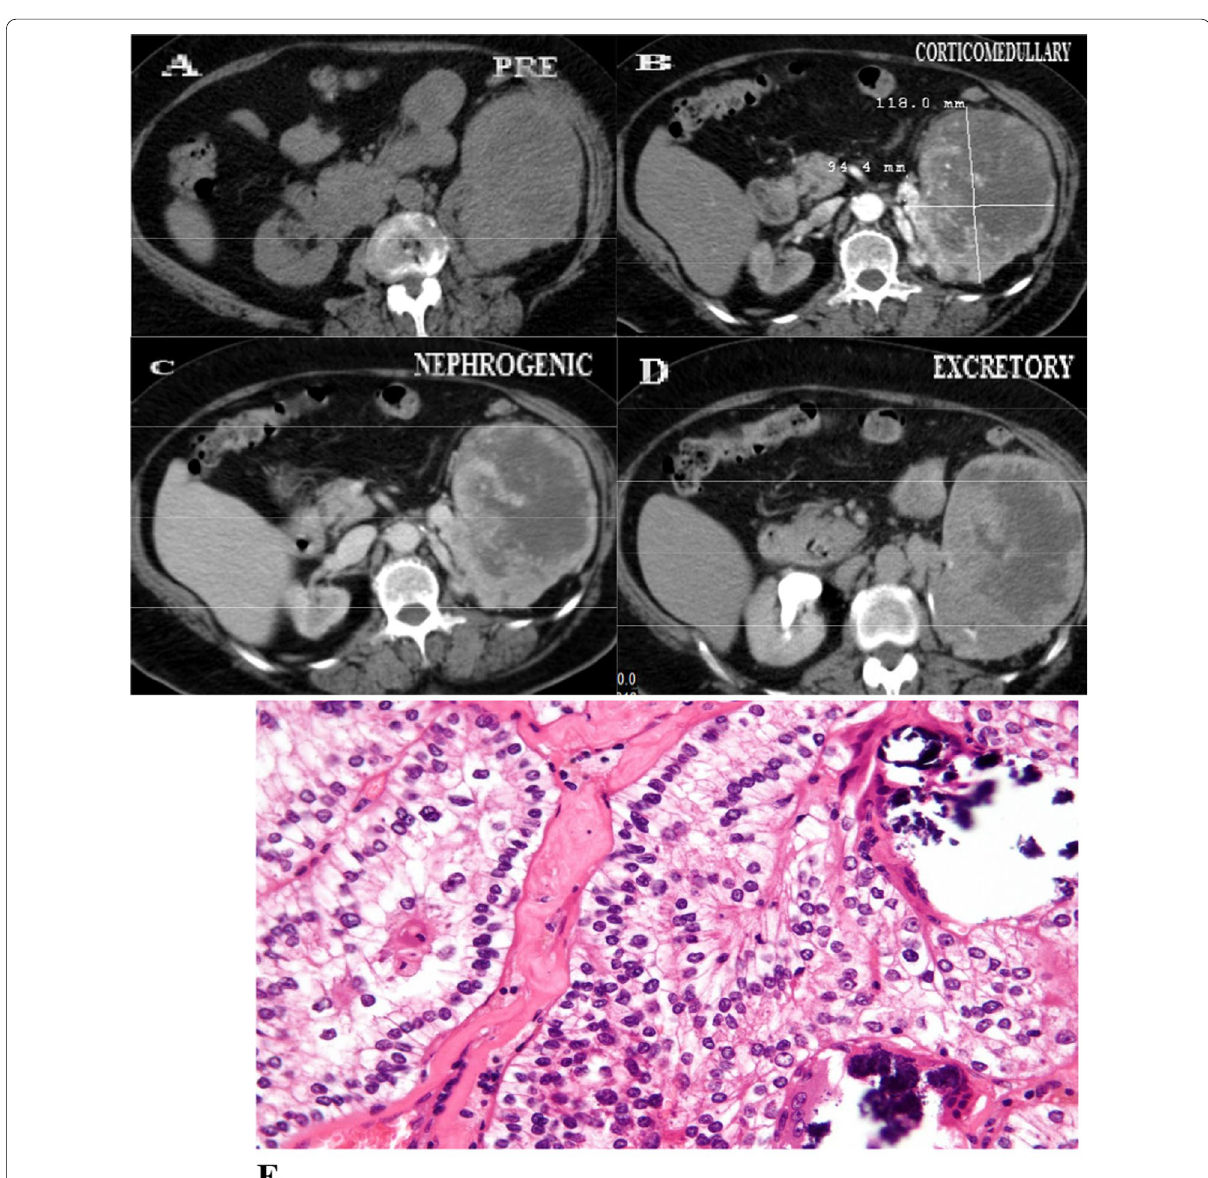
Fig. 1 XP11 translocation renal cell carcinoma. 39-year-old woman with left loin pain. Shows large 11 hyperattenuating renal mass with mean attenuation (41 HU) in pre enhanced phase ( A ) with large necrotic portion and Posterior solid component mean attenuation value of the lesion 91 HU in the corticomedullary phase ( B ).100 HU in the nephrographic phase ( C ) 80HU in the delayed phase ( D ). Histopathological diagnosis: xp11 RCC (Image E